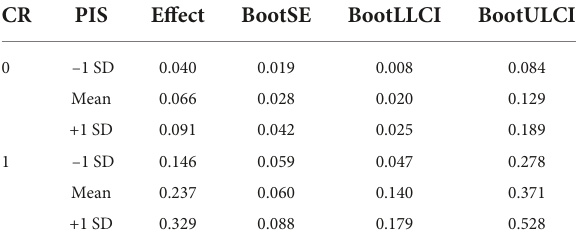
TABLE 8 Result of the conditional moderated mediation effect.